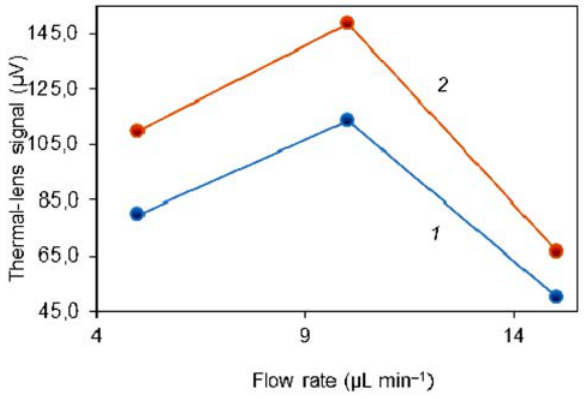
Figure 3. Dependence of the thermal-lens signal of Cr(VI) (4 μmol L –1 ) complex with diphenylcarbazide (20 μmol L –1 ) on the flow ra- te for two injection volumes of the reagent ( 1 ) 0.9 μL and ( 2 ) 1.4 μL, the detection distance from the mixing point, 29 cm; excitation power, 100 mW.